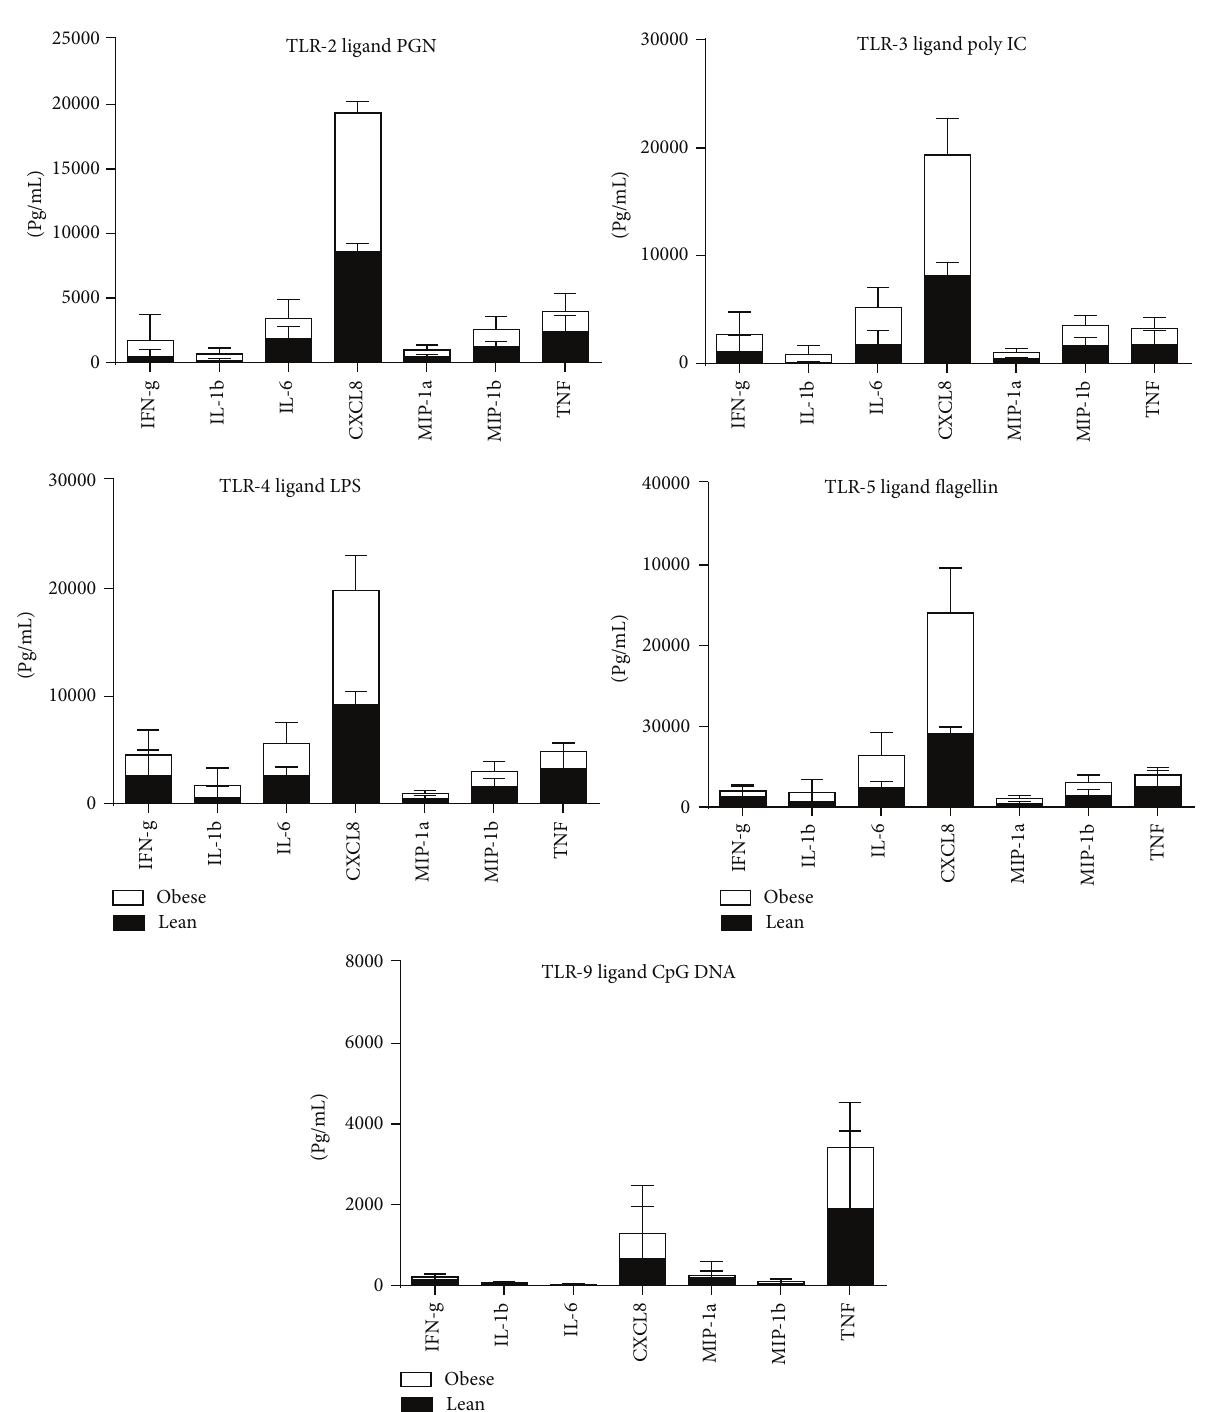
Figure 6: Measurement of cytokines in PBMCs stimulated with TLR ligands. PBMCs isolated from lean and obese chimpanzee blood were stimulated with TLR ligands for 20hr and supernatants were measured for cytokines using Bio-Rad 200, Luminex technology as described above. The results are expressed as pg/mL concentration. The results shown are an average of two distinct experiments. Comparison between groups of chimpanzees was done by one-way analysis of variance with the Kruskal-Wallis test as described